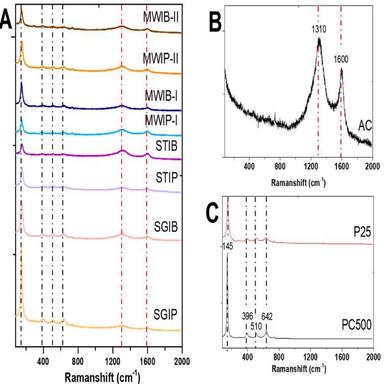
Ramanshift patterns of the (A) TiO2/AC heterostructures; (B) pristine AC; and (C) pristine P25 and PC500. The dotted black lines are related to TiO2 bands, and the dotted red lines are related to AC bands.